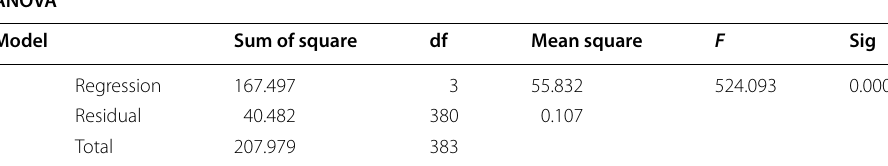
Dependent variable: competitive growth